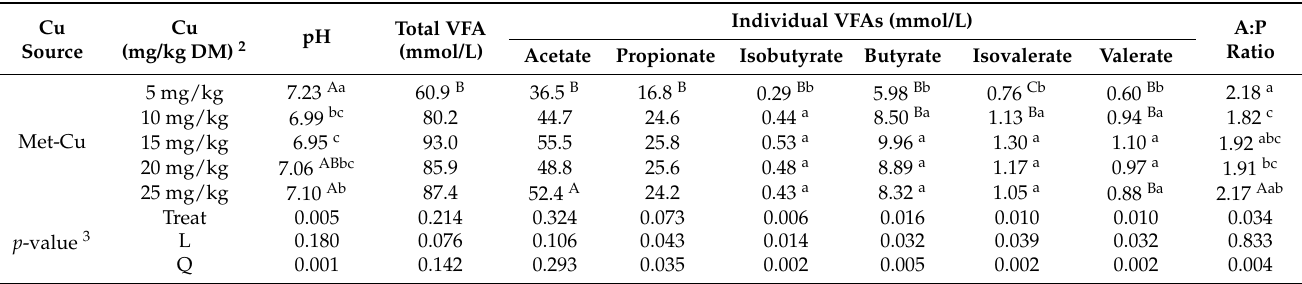
Table 3. In vitro pH, total volatile fatty acids (VFAs) and individual VFAs and acetate:propionate (A:P) ratio from substrate with added copper (Cu) from different sources at different levels 1